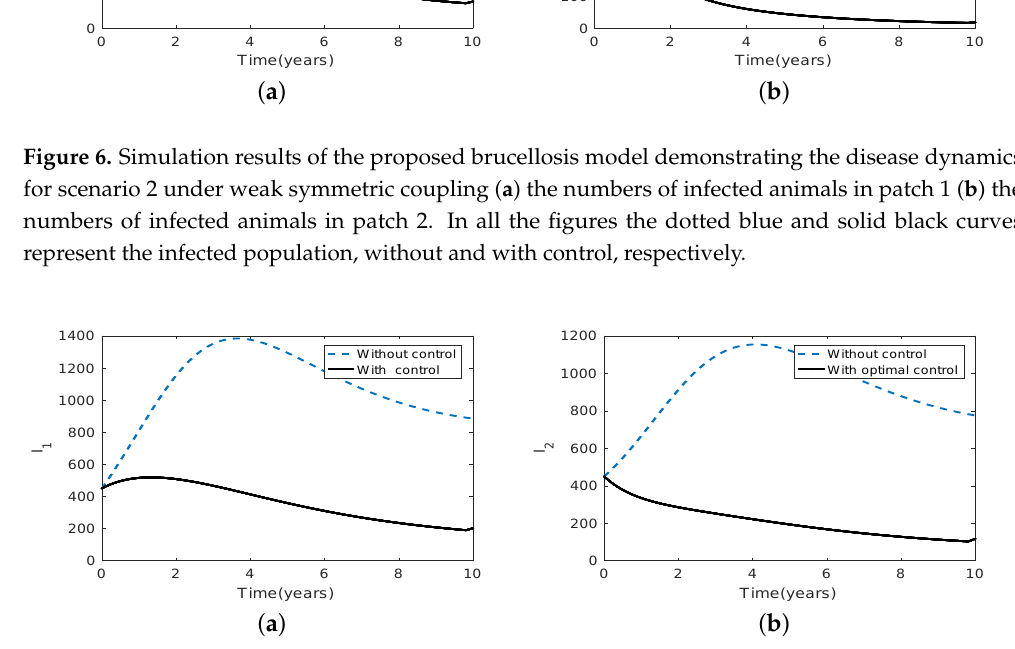
Figure 7. Simulation results of the proposed brucellosis model demonstrating the disease dynamics for scenario 2 under strong symmetric coupling ( a ) the numbers of infected animals in patch 1 ( b ) the numbers of infected animals in patch 2. In all the figures the dotted blue and solid black curves represent the infected population, without and with control, respectively.